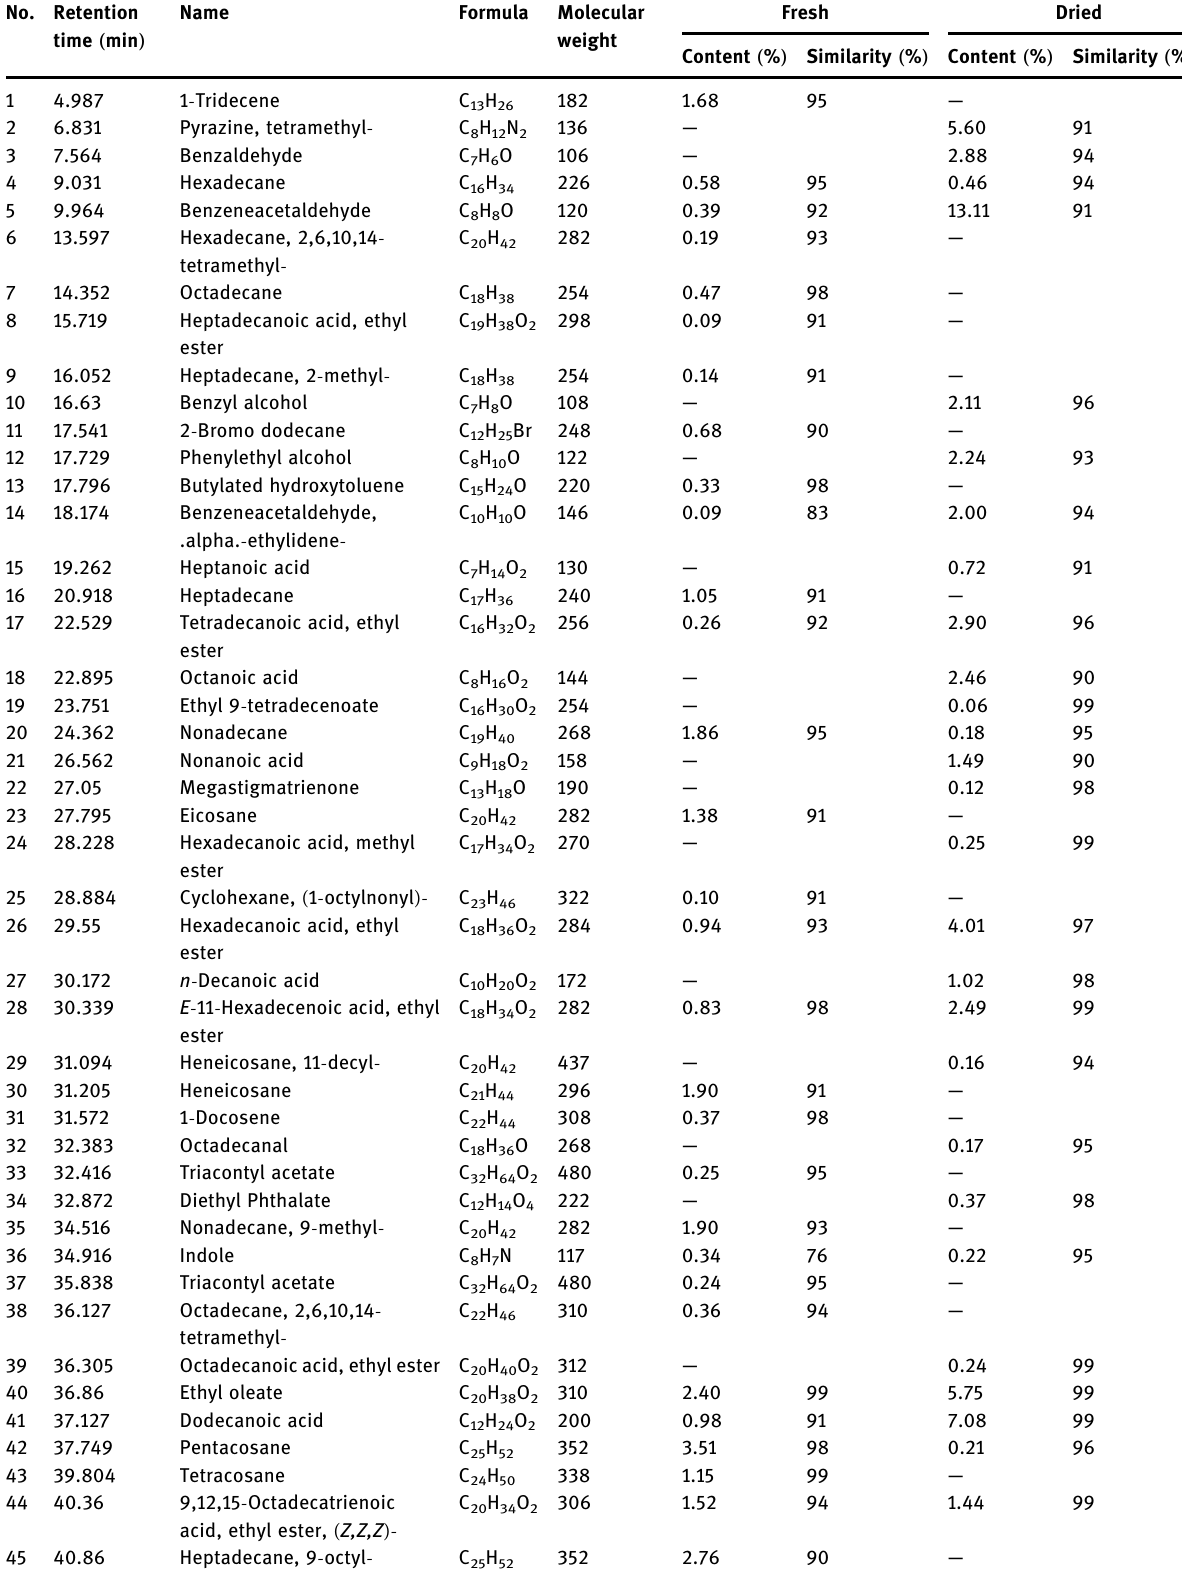
Table 2: Volatile composition in the petroleum ether parts of the fresh and dried V. auraria No.